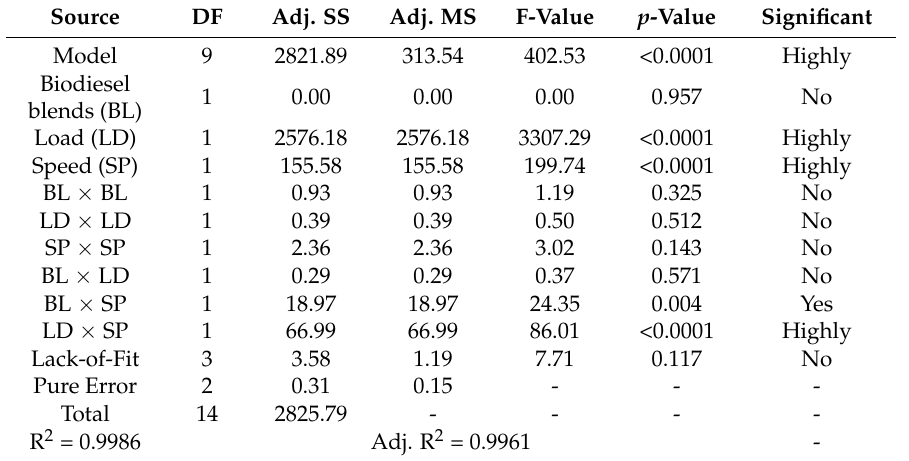
Table 8. ANOVA results of the interactive effect of biodiesel blends, load, and speed on brake power. Source DF Adj. SS Adj. MS F-Value p